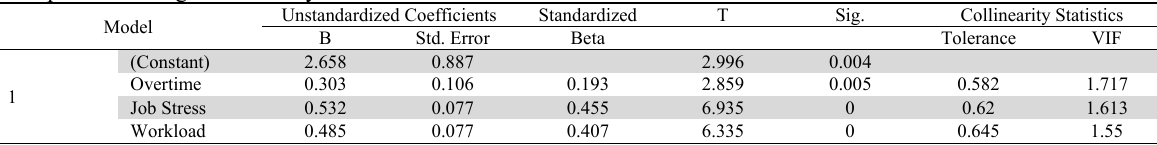
Multiple Linear Regression Analysis